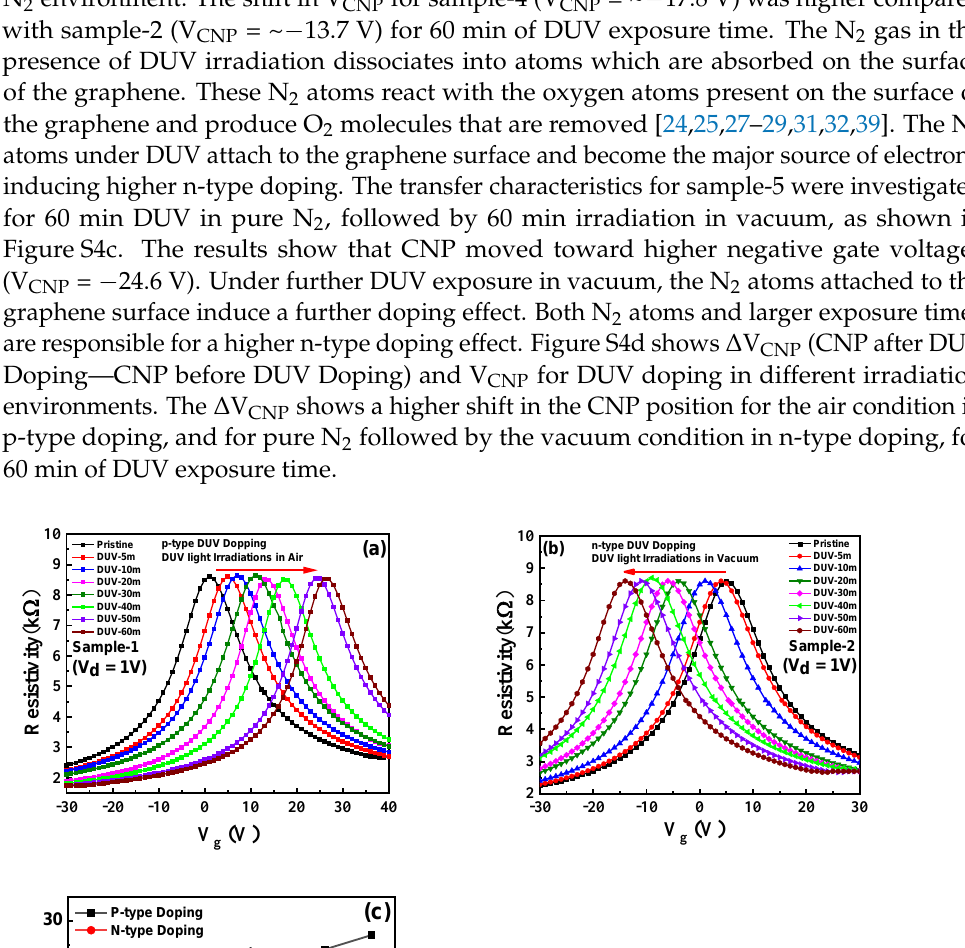
6 of 16 Figure 3. Raman spectroscopy analysis: ( a ) Raman spectra of pristine graphene and n-type doped sample-2, by DUV irradiation in vacuum with different exposure times, showing the redshift in 2D and G peaks towards smaller wavenumbers . ( b ) A shift in 2D and G peak intensity ratios with an increment in DUV exposure times. ( c ) The 2D and G peak positions as a function of DUV exposure times, showing the shift towards smaller wavenumbers with an increase in n-type doping effect by DUV irradiation in vacuum.